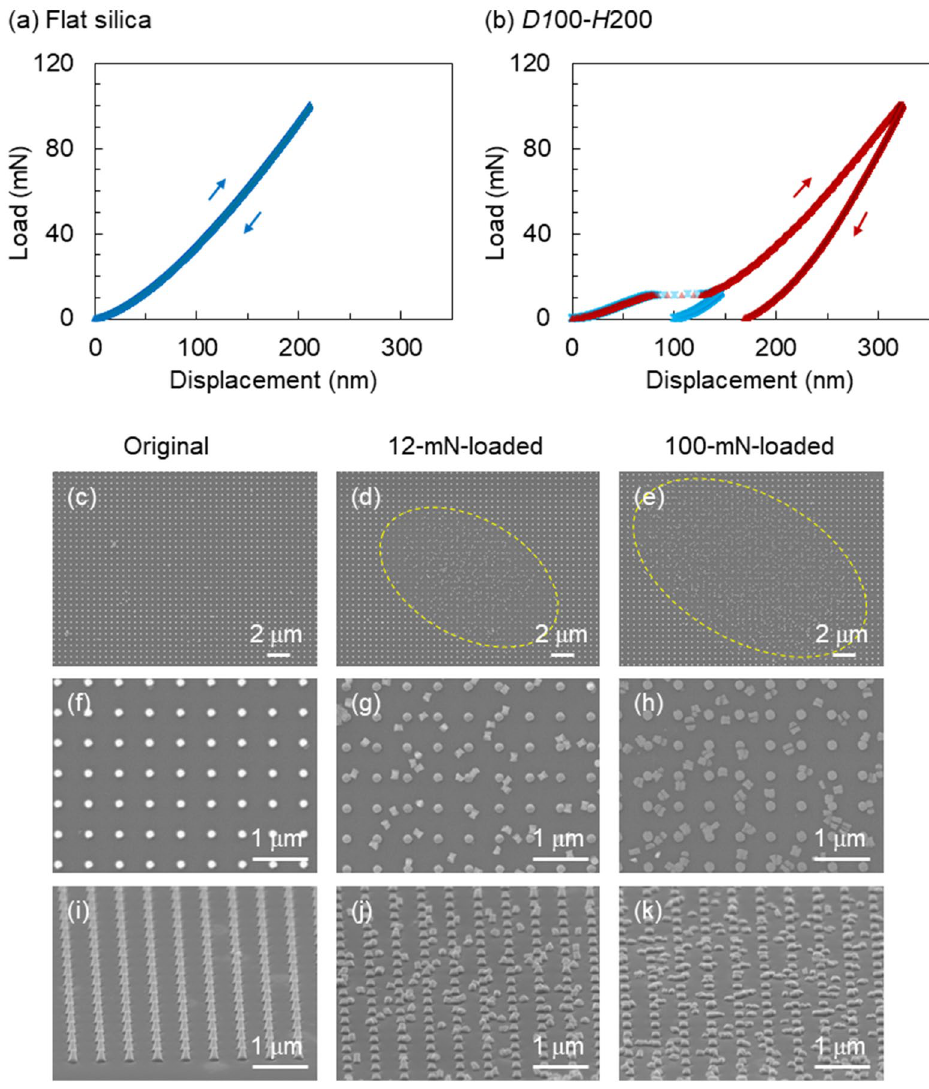
Figure 2. ( a , b ) Load–displacement curves of SQ with ( a ) a flat surface until a peak load of 100 mN and ( b ) D 100– H 200 nanopillars until a peak load of 12 mN (blue plots) and 100 mN (red plots) measured by nanoindentation. ( c – h ) Surface and ( i – k ) tilted SEM images of the ( c , f , i ) original D 100– H 100 SQ nanopillars and those after deformation via nanoindentation until a peak load of ( d , g , j ) 12 mN and ( e , h , k ) 100